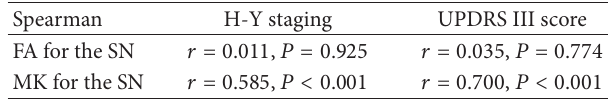
Table 3: Correlation analyses of FA and MK for the SN with H-Y staging and UPDRS III scores.